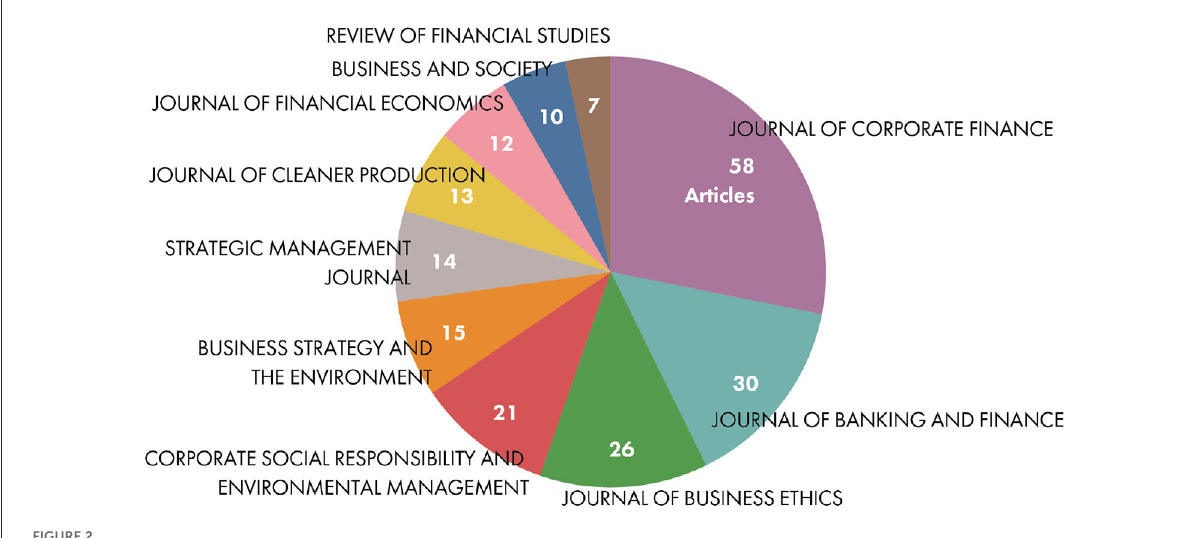
FIGURE2 The number of publications among the selected empirical